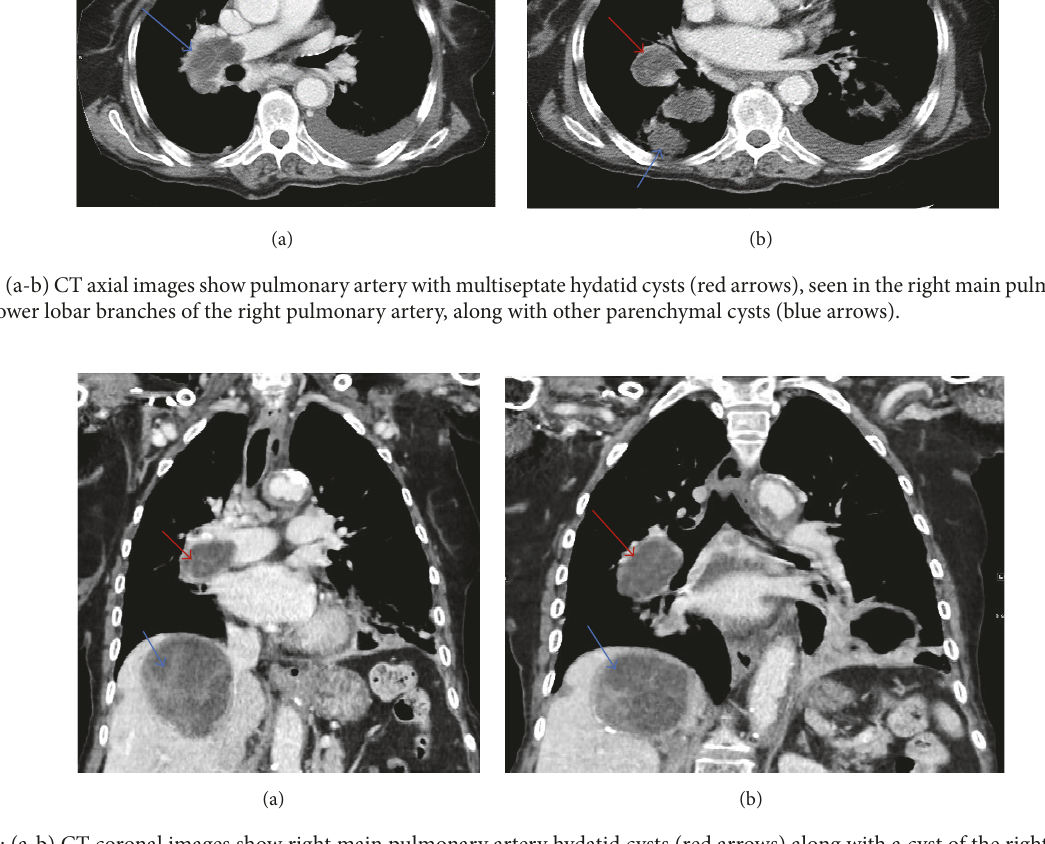
Figure 2: (a-b) CT coronal images show right main pulmonary artery hydatid cysts (red arrows) along with a cyst of the right hepatic lobe (blue arrows).